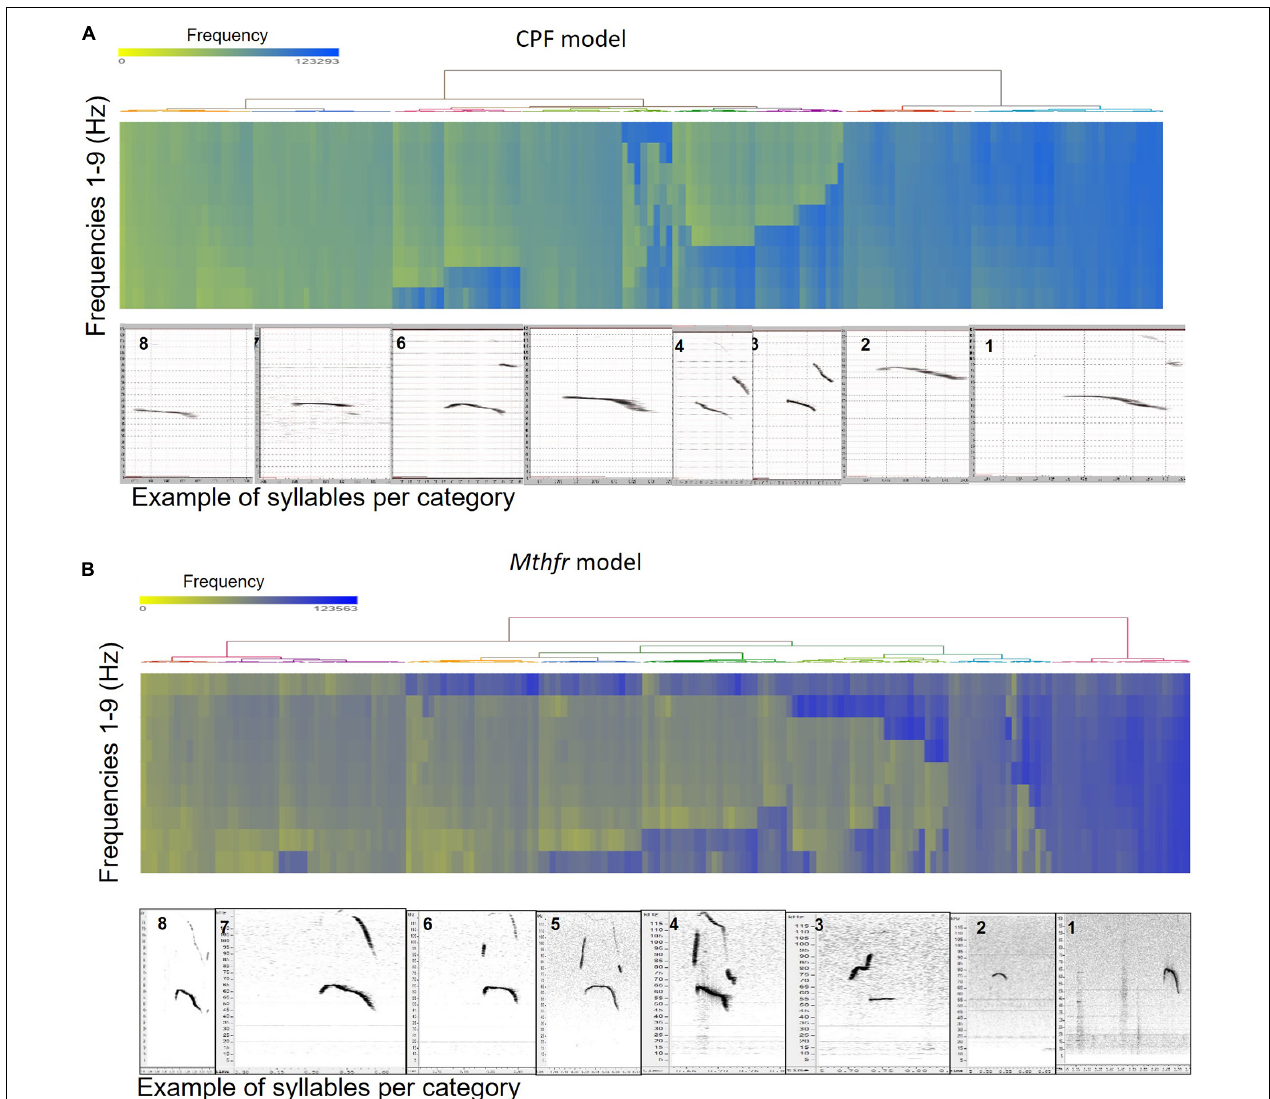
FIGURE 2 | Hierarchical clustering of syllable spectral properties resulted in eight distinct clusters for each ASD model. Hierarchical clustering dendrogram and heat-map for the CPF model (A) and the Mthfr model (B) . Frequencies in the heat map range from high frequencies in blue to low frequencies in yellow. Examples of syllables from each cluster, as generated by Avisoft SASLab Pro ver5.2.11 software, numbered as in the text and tables, are shown below each